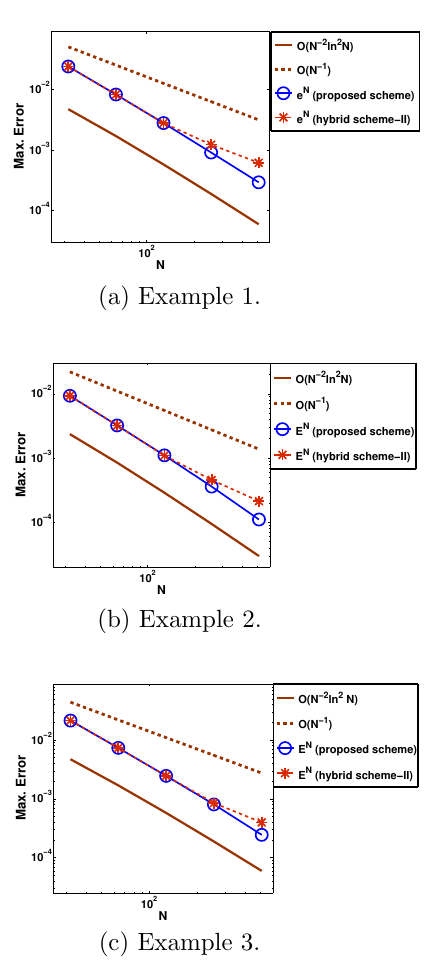
Figure 6. Loglog plot of ε -uniform maximum point-wise